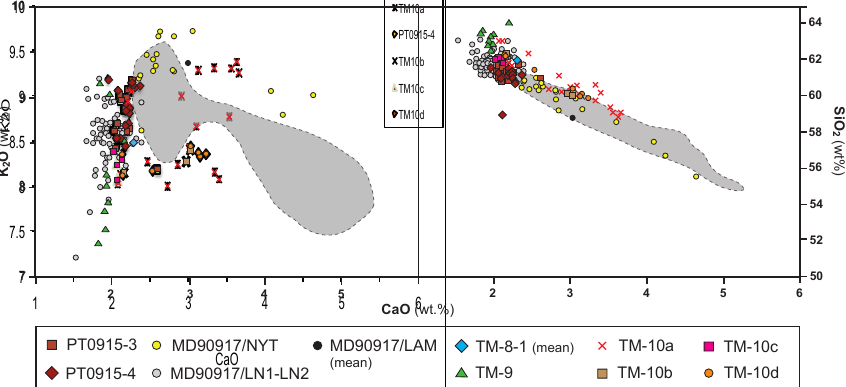
Fig. 8. K 2 O vs. CaO and SiO 2 vs. CaO diagrams (modified after Pabst et al., 2008) showing the geochemical discrimination between NYT and pre-NYT deposits (dotted lines – NYT, Orsi et al., 1995; TM-8-1, Wulf, personal communication, 2012; TM-9, Wulf et al., 2004;